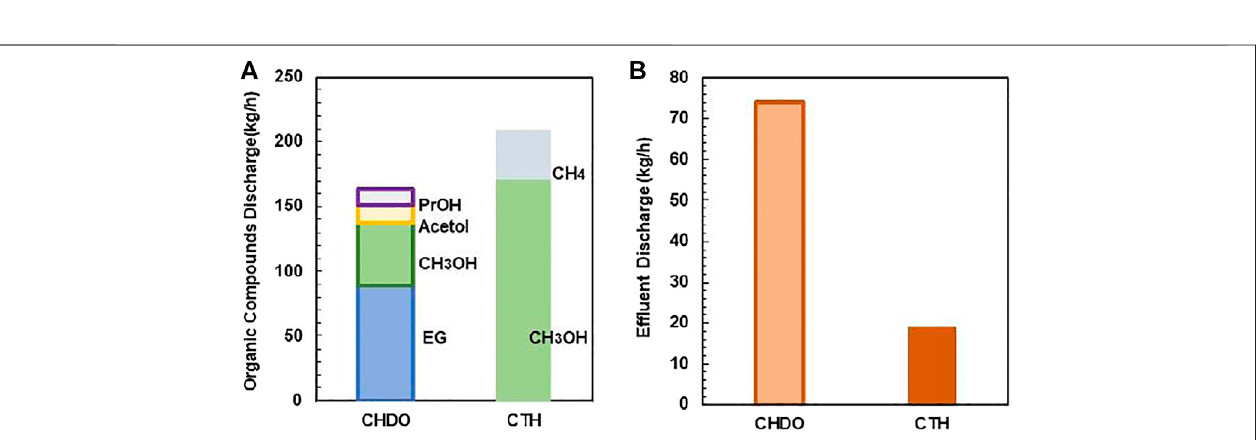
FIGURE 10 | The direct and indirect emission of CO 2 in CTH and CHDO (A) . Equivalent greenhouse gas emissions of CHDO and CTH (B) .